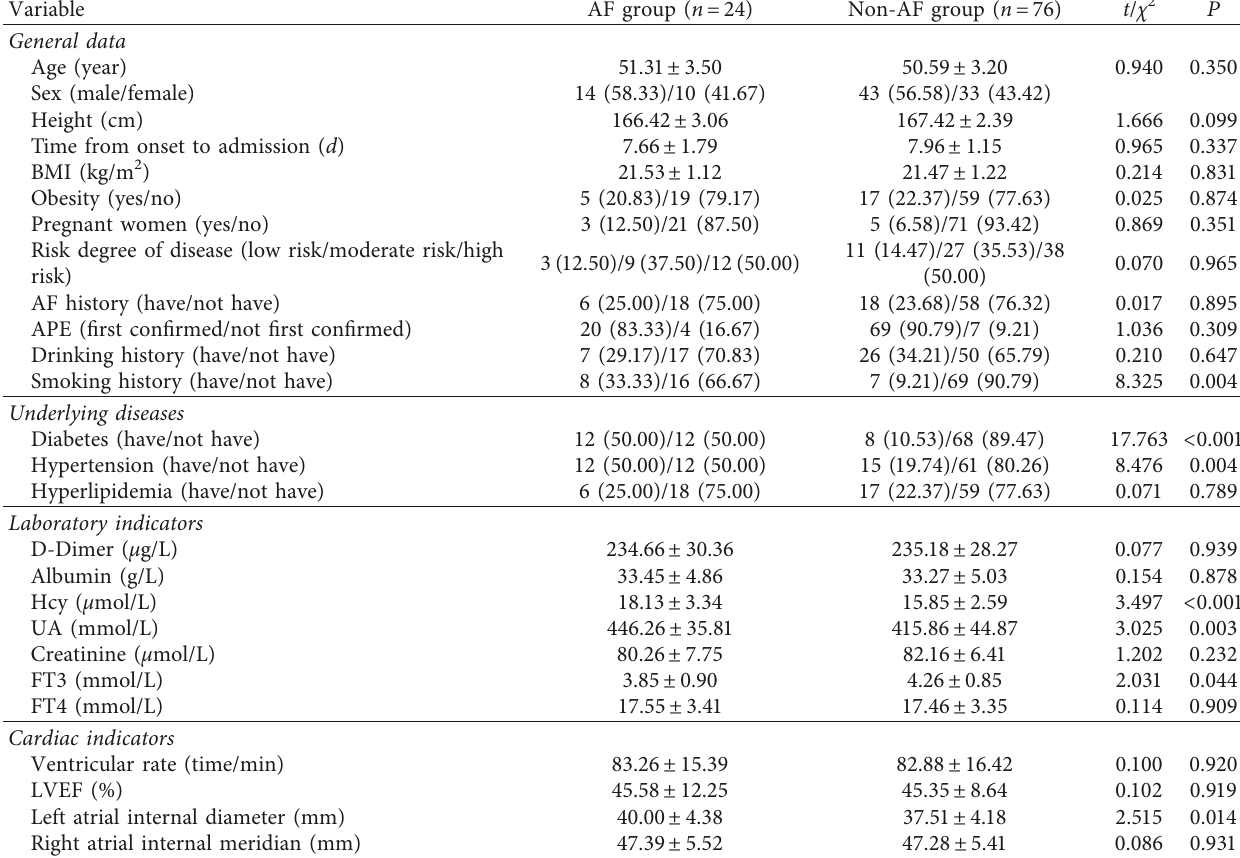
Table 1: Univariate analysis of risk factors for AF in patients with AP ( x ± s / n